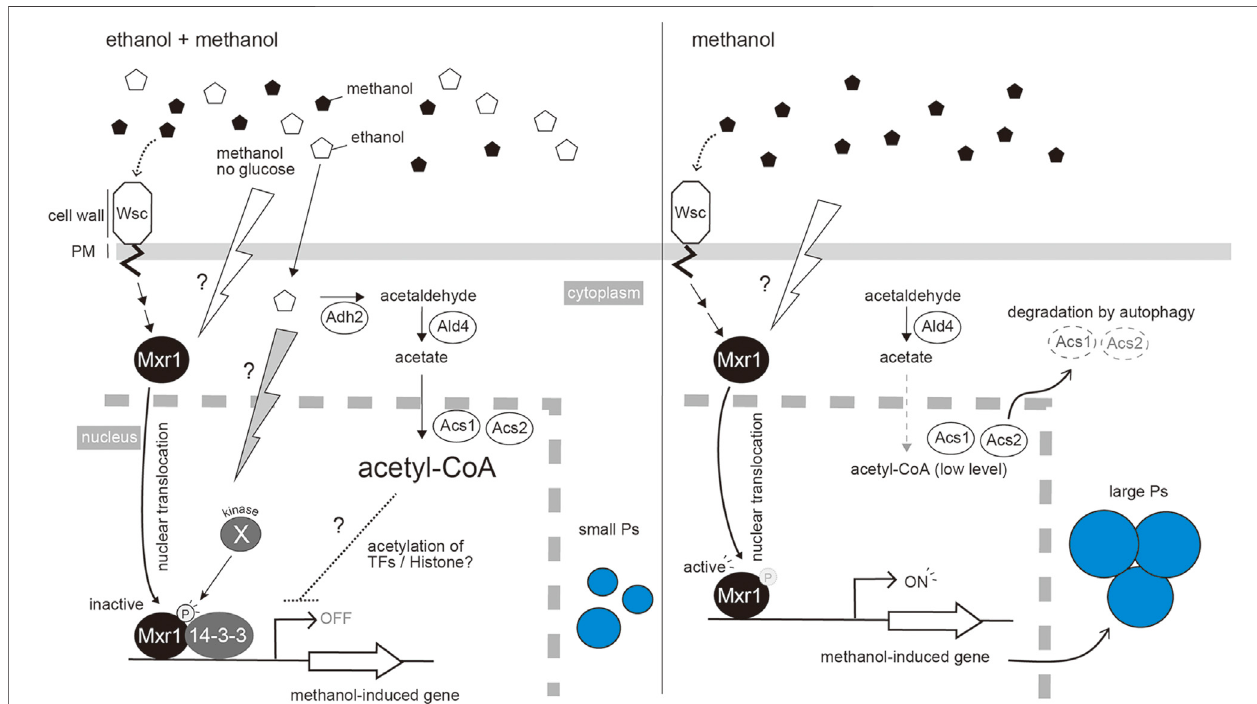
FIGURE 2 | Repression of methanol-induced peroxisome proliferation by the co-presence of ethanol. Ethanol is metabolized to Acetyl-CoA by the sequential reactions catalyzed by Adh2, Ald4, Acs1 and Acs2. Acetyl-CoA then represses methanol-induced gene expression. As in S. cerevisiae , acetyl-CoA may be utilized for acetylationofhistonesorothertranscriptionfactorsthatrepresstheexpressionofmethanol-inducedgenes(Takahashietal.,2006).Mxr1isakeytranscriptionfactorfor methanol-inducedgeneexpression.Thepresenceofmethanol,orremovalofglucose,changesthelocalizationofMxr1fromthecytoplasmtothenucleus,whereit canbindtothepromoterregionsofmethanol-inducedgenes.Inthepresenceofethanol,anunidenti fi edkinaseinactivatesMxr1byphosphorylationattheserineresidue S215, which causes the interactionwith14-3-3 protein inthe nucleus. This interaction inhibits thefunction ofKpMxr1 activation domain (Parua et al., 2012) (left panel) . This process occurs independently of the acetyl-CoA pathway component. Changing to methanol media or depleting ethanol stimulates the dephosphorylated Mxr1 to activate the expression of methanol-induced genes. To release the ethanol repression effectively, Acs1 and Acs2 are degraded by autophagy (right panel) .